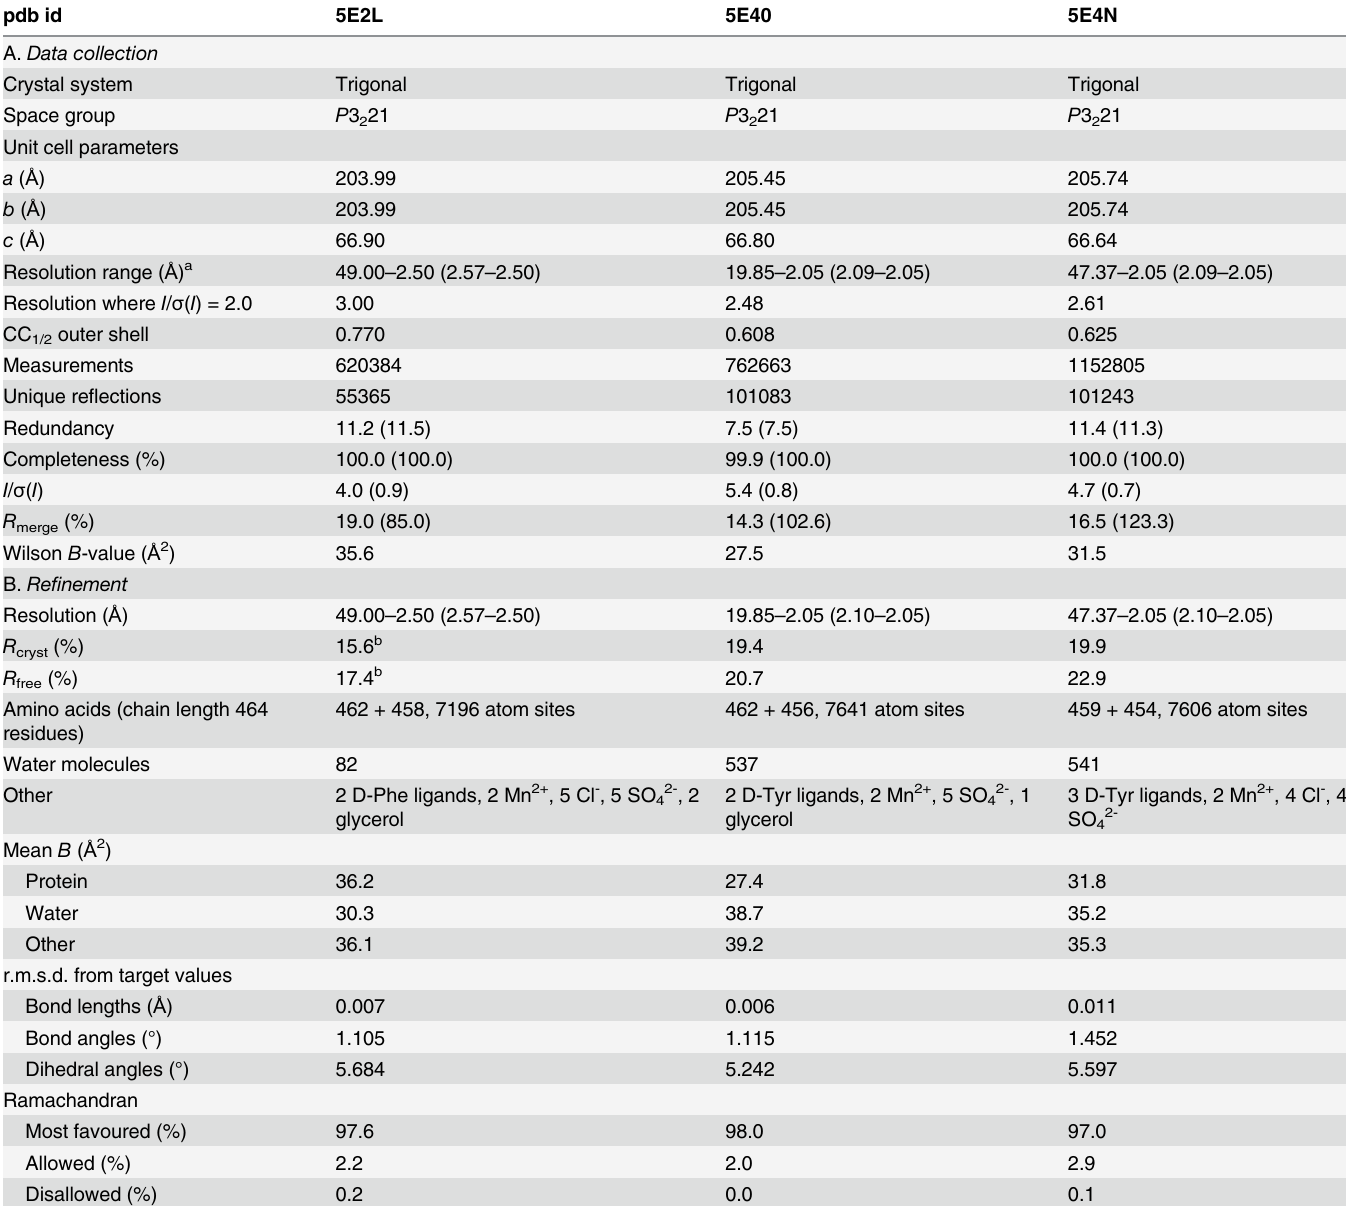
Table 3. Data collection and refinement statistics for structures reported in this publication (see also Table